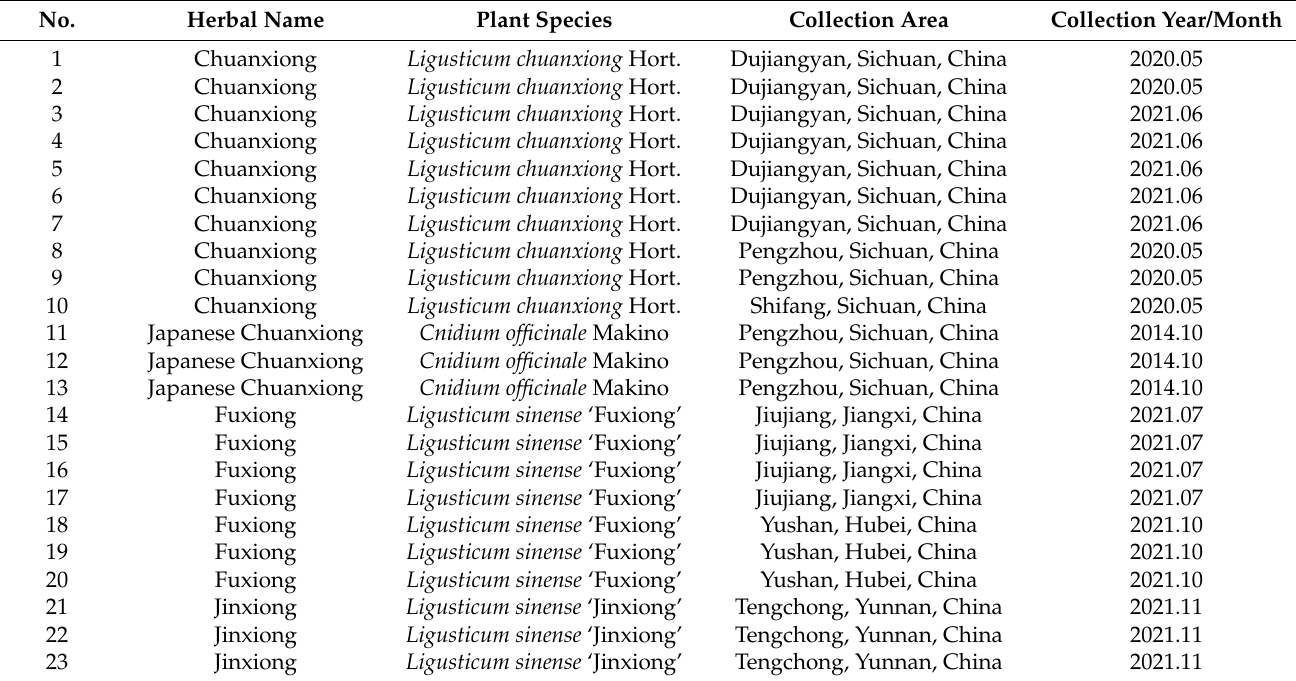
Table 1. Information of Herb